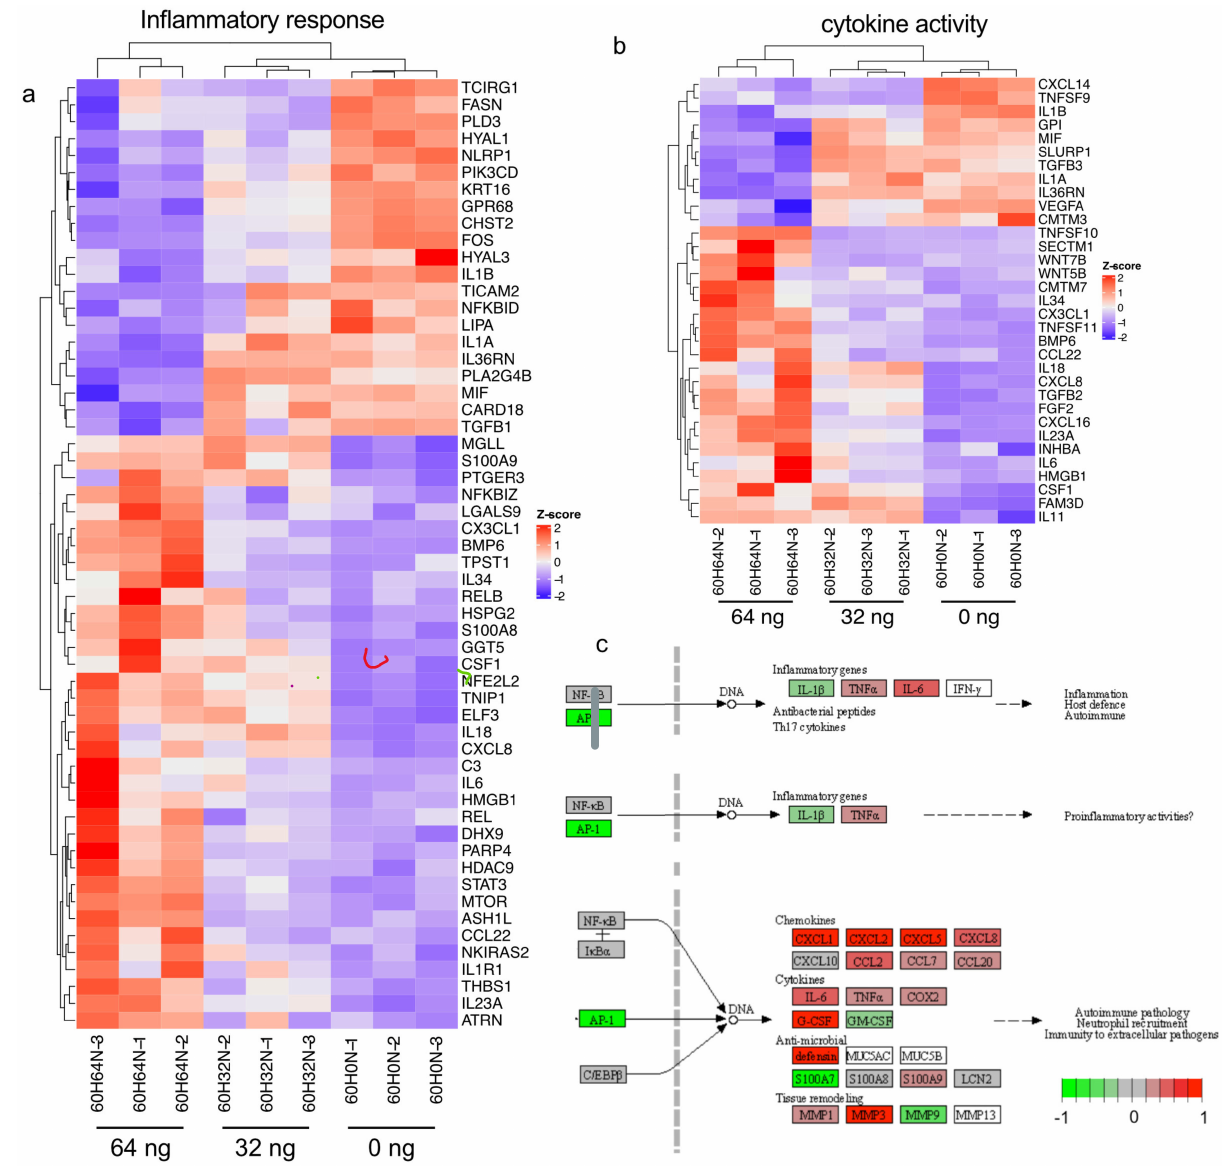
Figure 3. Effect of everolimus treatment on proinflammatory cytokines. ( a ) Heatmap illustrating RNA- Seq differential expression for genes associated with inflammatory response (GO:0006954, padj < 0.05). GO enrichment analysis for biological processes. ( b ) Heatmap illustrating RNA-Seq differential expression data for genes associated with cytokine activity (GO:0005125, padj < 0.01). ( c ) Pathview image showing a selection of inflammation and cytokines (in tissue treated with 64 ng everolimus compared with untreated after 60 h) (green means downregulated and red means upregulated). (Supplementary Figure S1 is the full